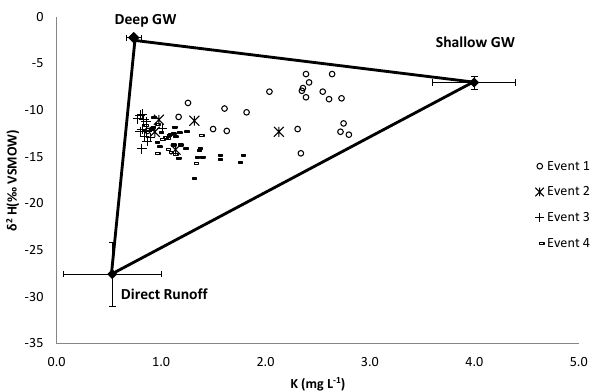
Figure 11. Mixing diagram of δ 2 H and K showing streamwater samples at the outlet for four rain events during the 2013–2014 wet